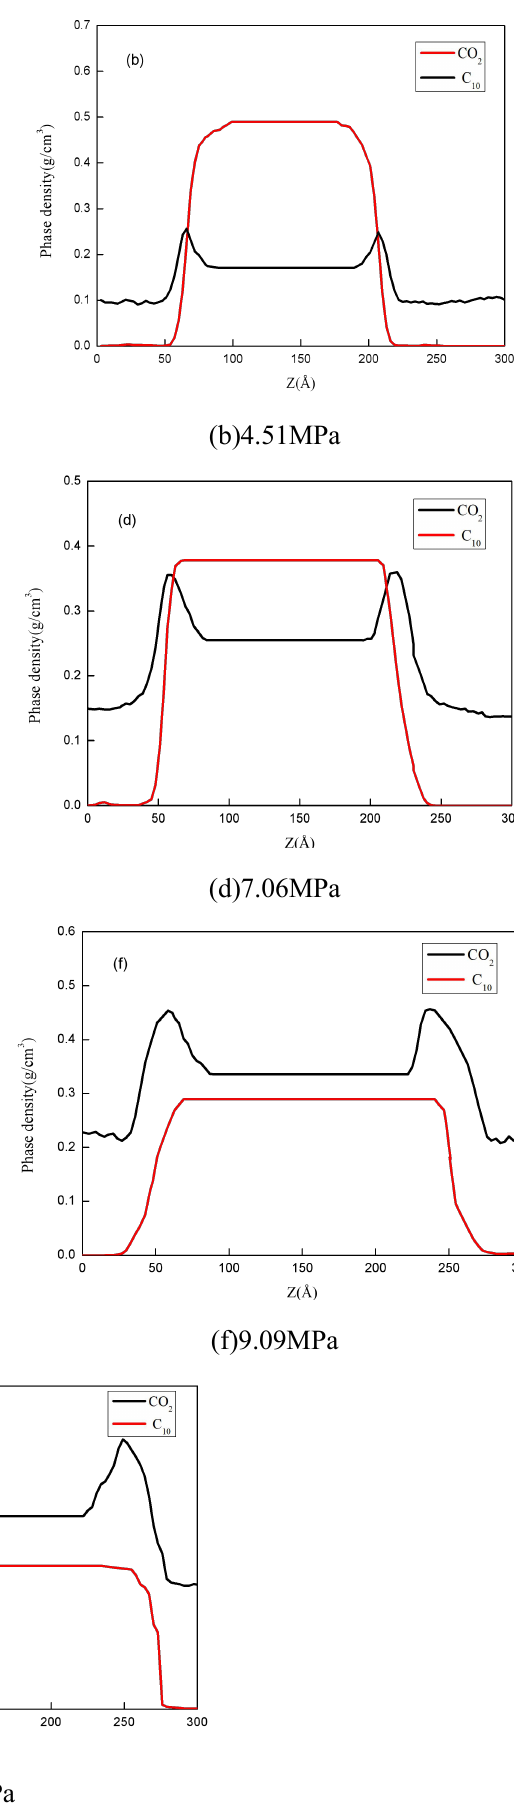
Figure 5 — Density distribution of components of CO 2 /n-decane system at different